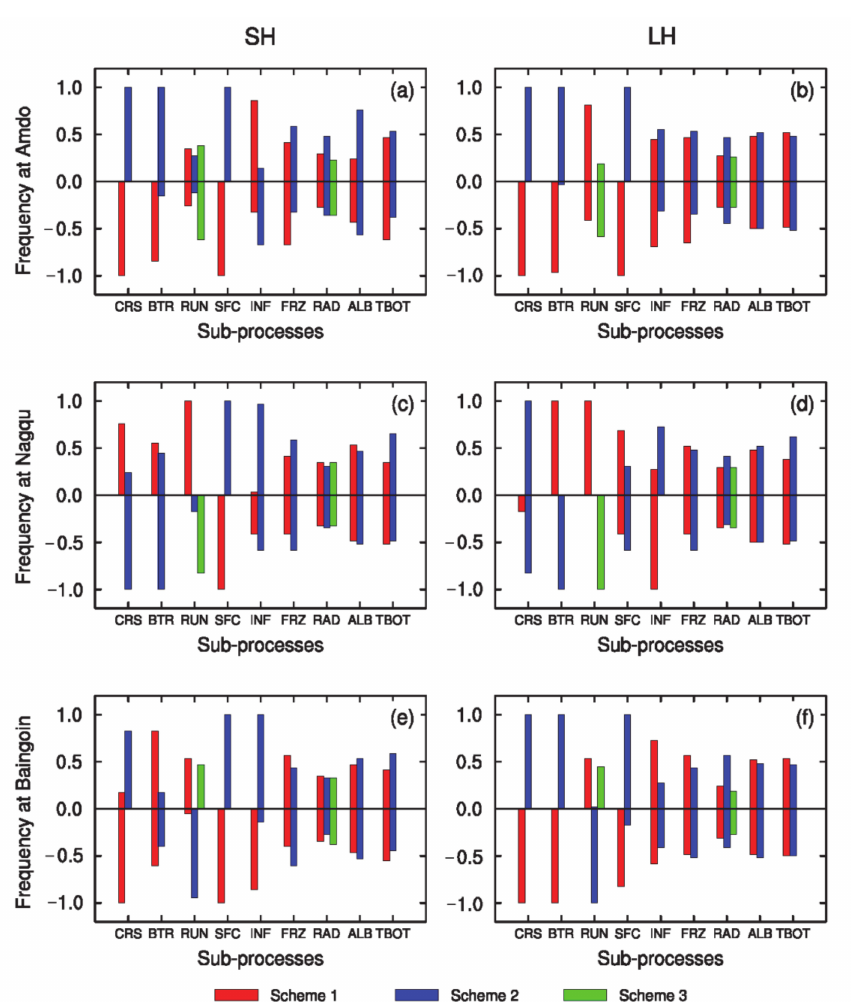
Figure 6. The selected frequency of di ff erent schemes of each subprocess for (left panel) SH and (right panel) LH in the best members (0–1) or worst members ( − 1–0) at the ( a , b ) Amdo, ( c , d ) Nagqu, and ( e , f ) Baingoin sites in ensemble experiment Ens1 when the in situ precipitation is